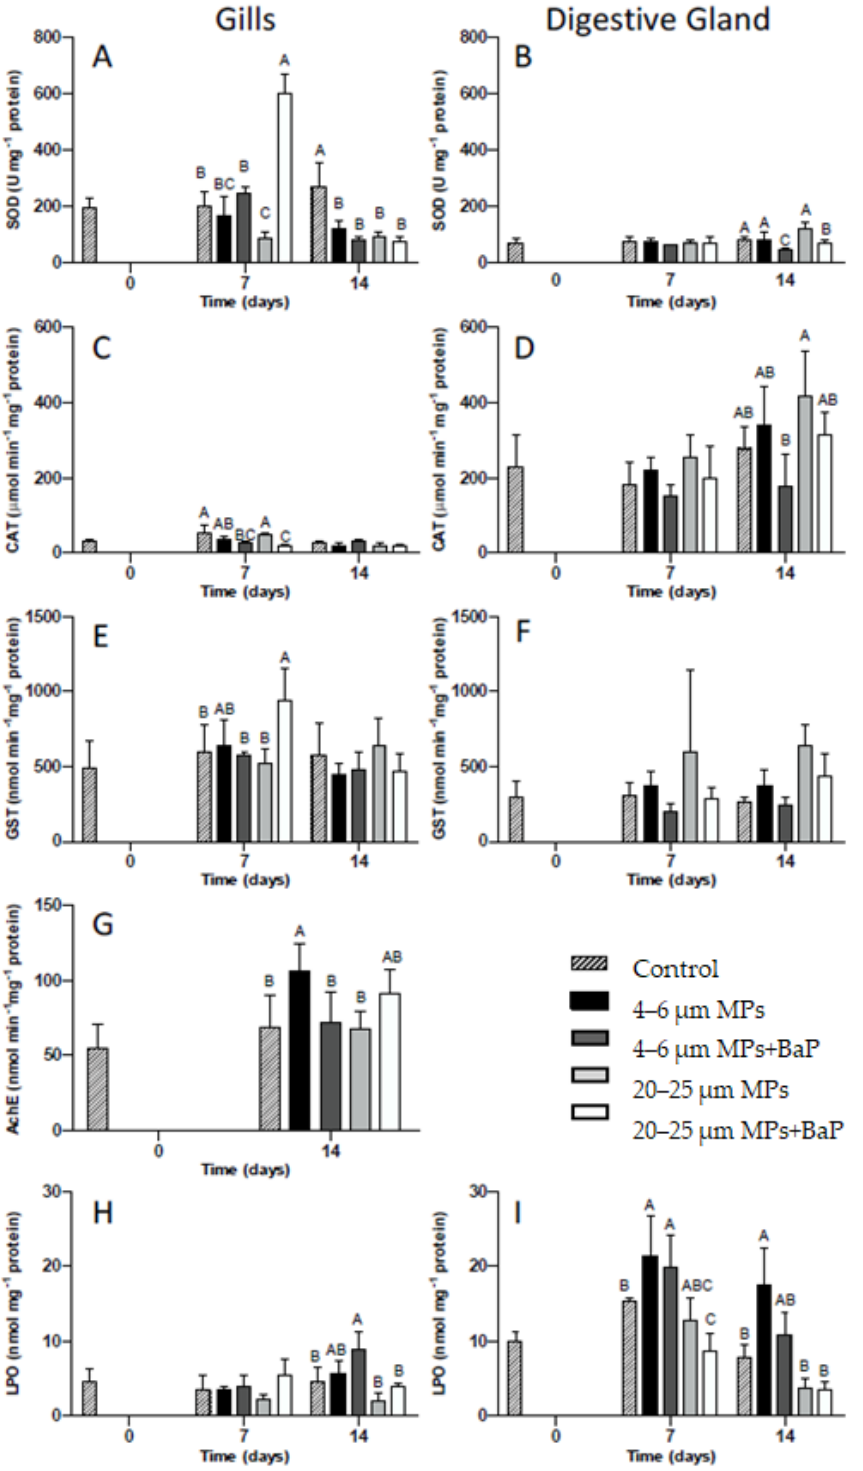
Figure 2. SOD ( A ), CAT ( C ), GST ( E ), AChE ( G ) activities and LPO ( H ) levels (mean ± SD) in the gills and SOD ( B ), CAT ( D ), GST ( F ), and LPO ( I ) levels in the digestive gland of S. plana unexposed and exposed to 4–6 µ m and 20–25 µ m MPs with and without BaP after 14 days of exposure. Different capital letters indicate a significant difference between treatments within the same time. ( p < 0.05). In relation to the digestive gland (Figure 2B), SOD activity is lower than in the gills. SOD activity in the digestive gland significantly decreases in clams exposed to 4–6 µ m